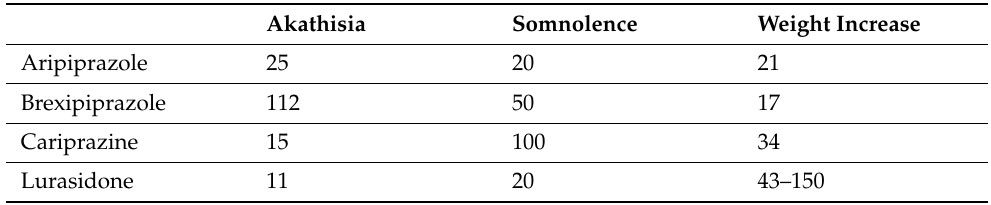
Table 8. Values of the number needed to harm for the most important adverse events of brexpiprazole, cariprazine, lurasidone, and aripiprazole in patients with schizophrenia according to